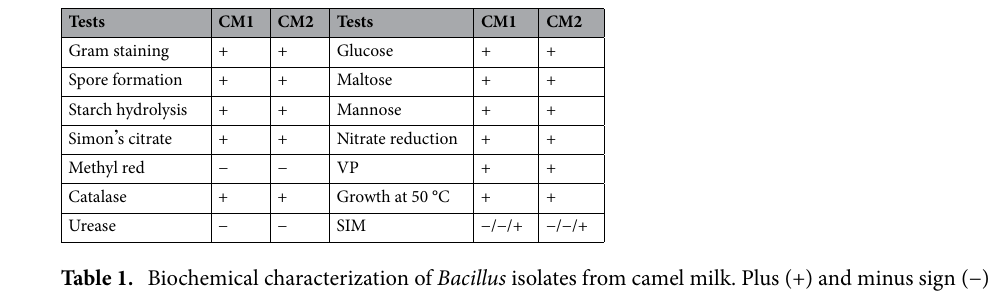
Table 1. Biochemical characterization of Bacillus isolates from camel milk. Plus (+) and minus sign (−) indicate the positive and negative results of reaction/test,